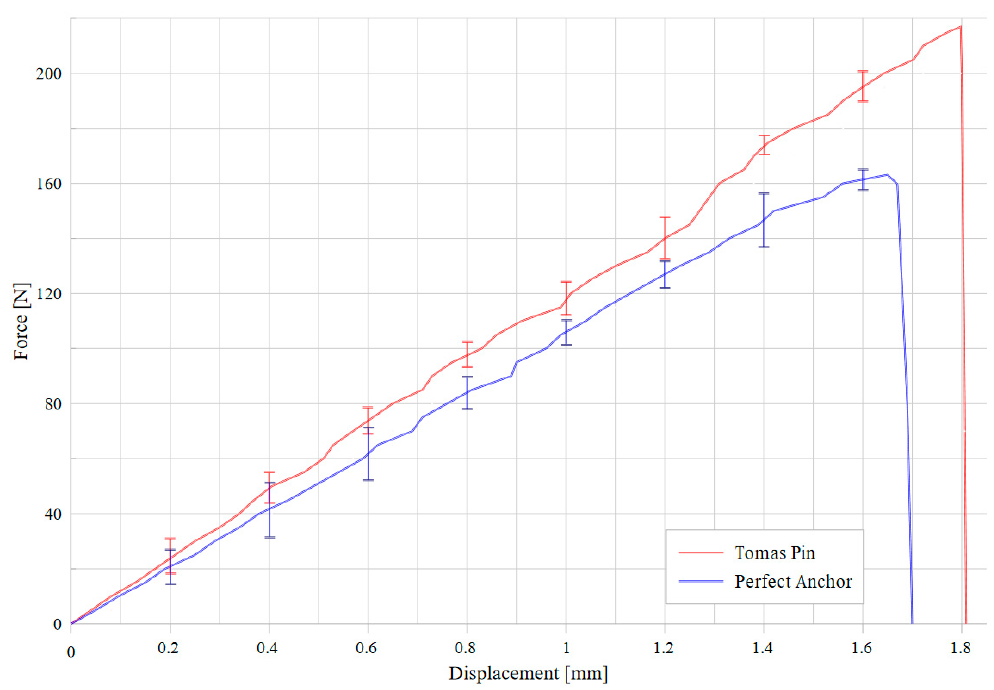
Figure 5. Mean values of pull-out forces of the 20 samples of both Tomas ® -pin and Perfect Anchor mini-implants.